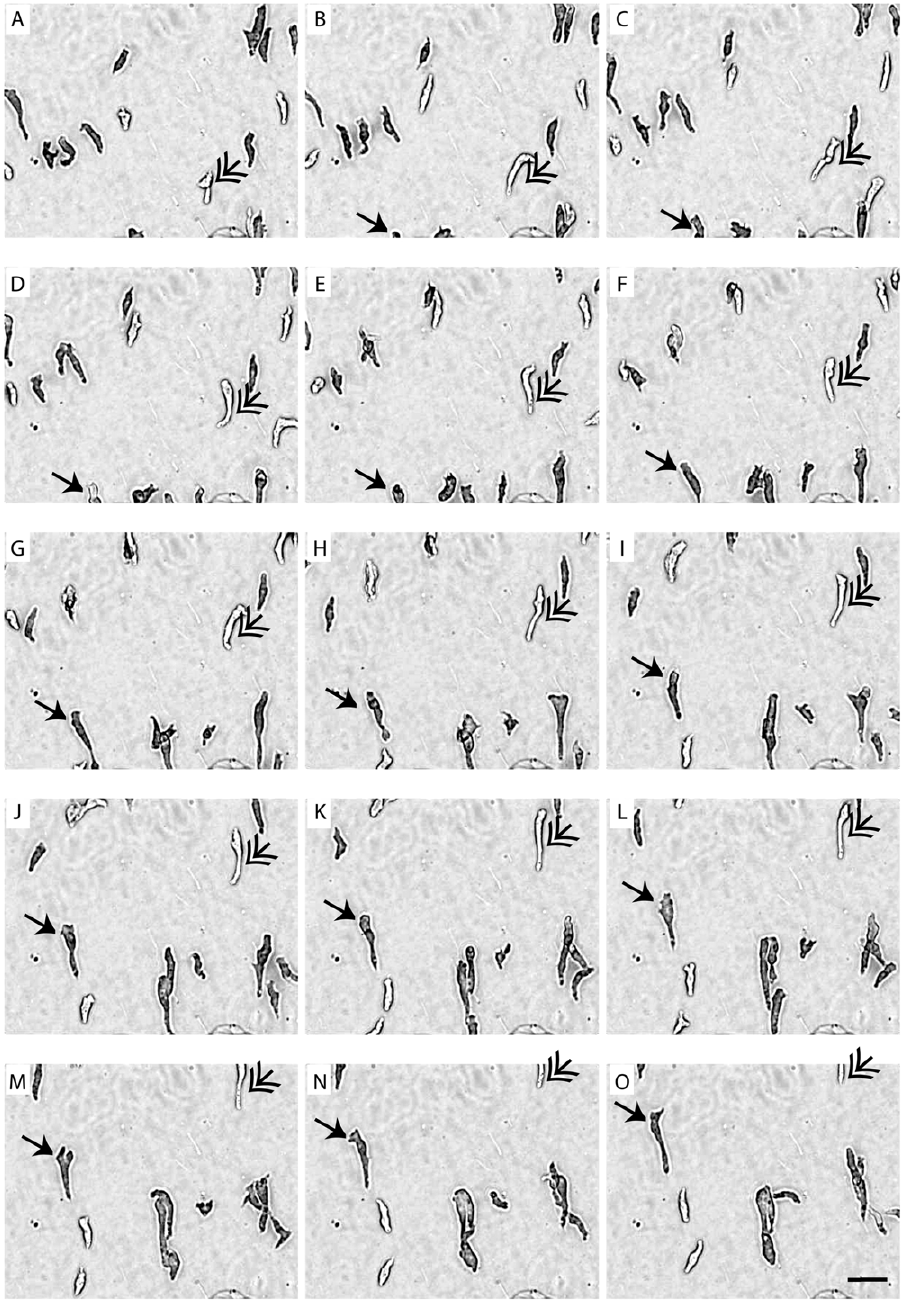
Figure 1. Time-dependent image series of Dictyostelium cells during chemotaxis. A–O: Cells moving towards a gradient of cAMP (5 m M) over a 15 min period, with images shown for each min. Two cells are indicated (arrows) over the test period. Bar =10 m m.